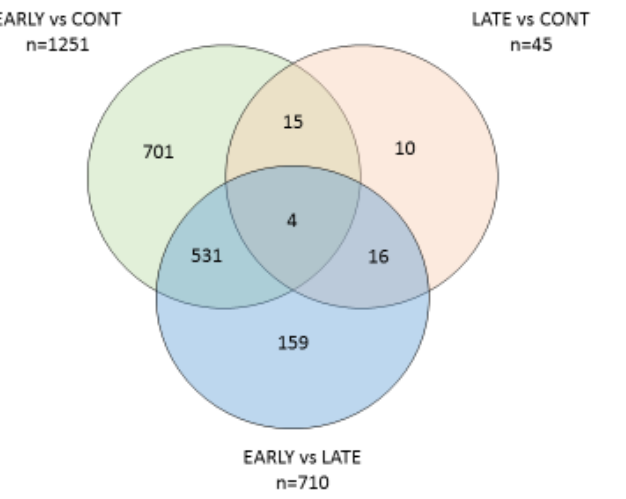
Figure 2. Venn diagram showing the numbers of DEGs identified between the three groups of cows.